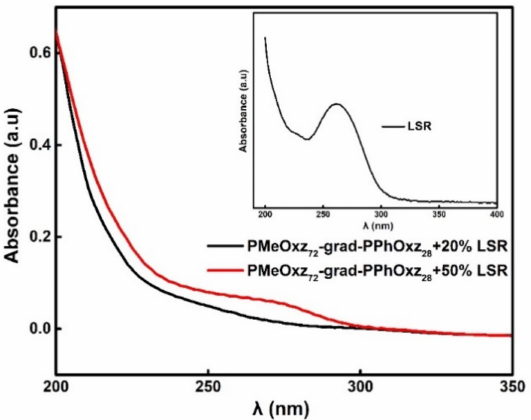
Figure 3. Comparison of UV-Vis spectra for LSR-loaded PMeOxz 72 -grad-PPhOxz 28